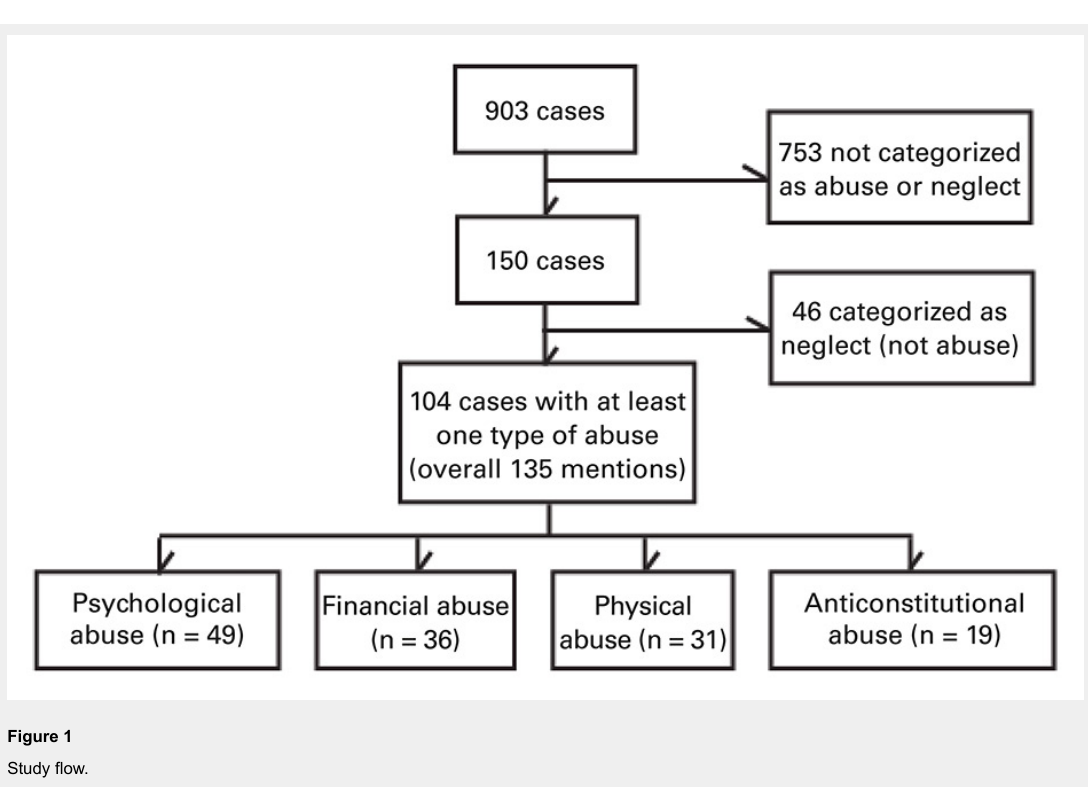
Figure 1 Study flow.